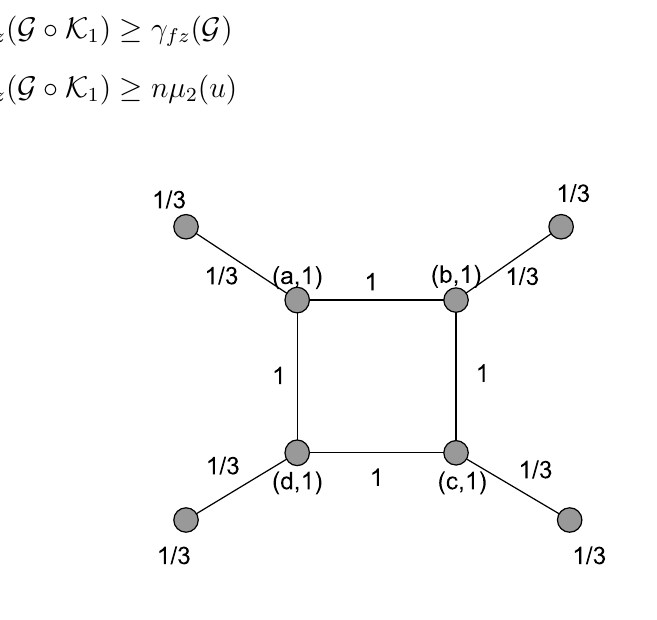
Figure 4: Fuzzy graph G ◦ K